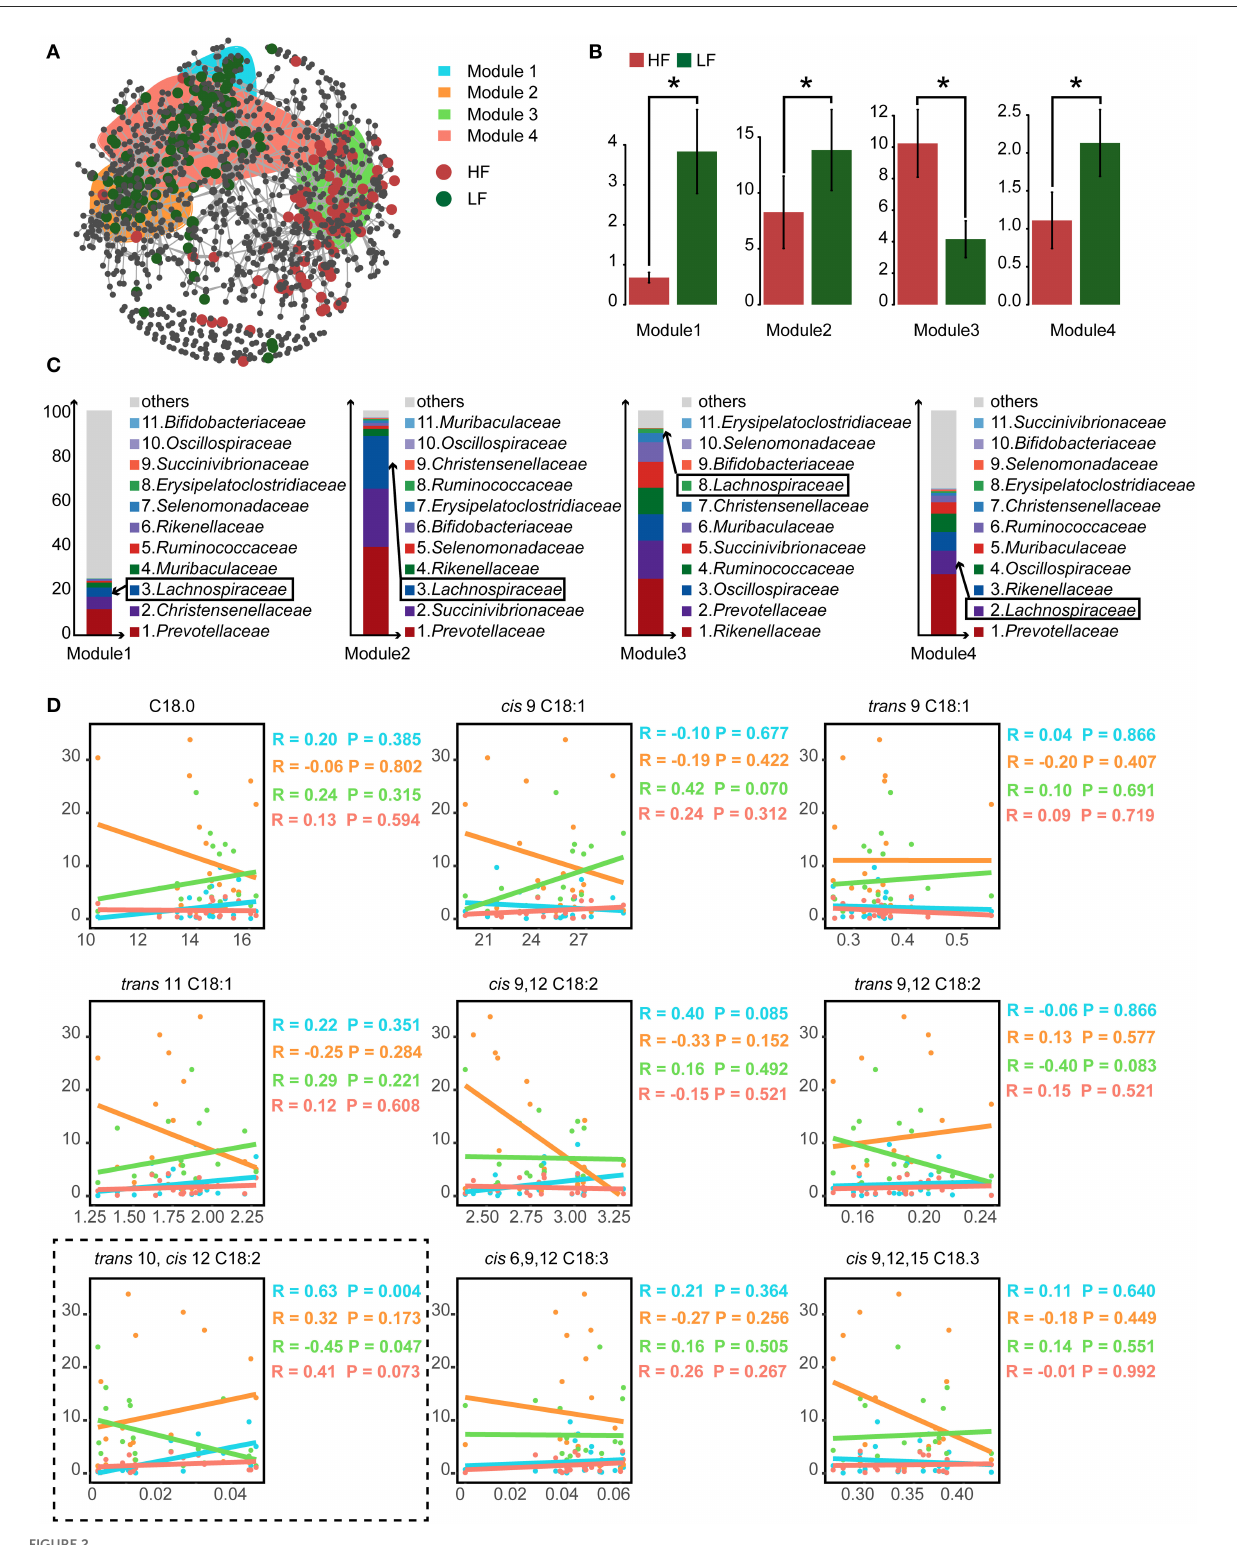
FIGURE2 (A) The cooccurrence network of the significantly different amplicon sequence variants (ASVs). (B) The relative abundance of the predominant modules who contained the largest number of significantly different ASVs. (C) The compositions of bacterial family of the predominant modules. The ranking of family was based on the relative abundance. The ranking of Lachnospiraceae was marked with the box. (D) The spearman correlations between the relative abundance of predominant modules and the relative content of milk C18 fatty acids (FA). HF, the top 10 cows with the highest milk fat percentage; LF, the last 10 cows with the lowest milk fat percentage. *indicated P < 0.05 in the Wilcoxon rank-sum